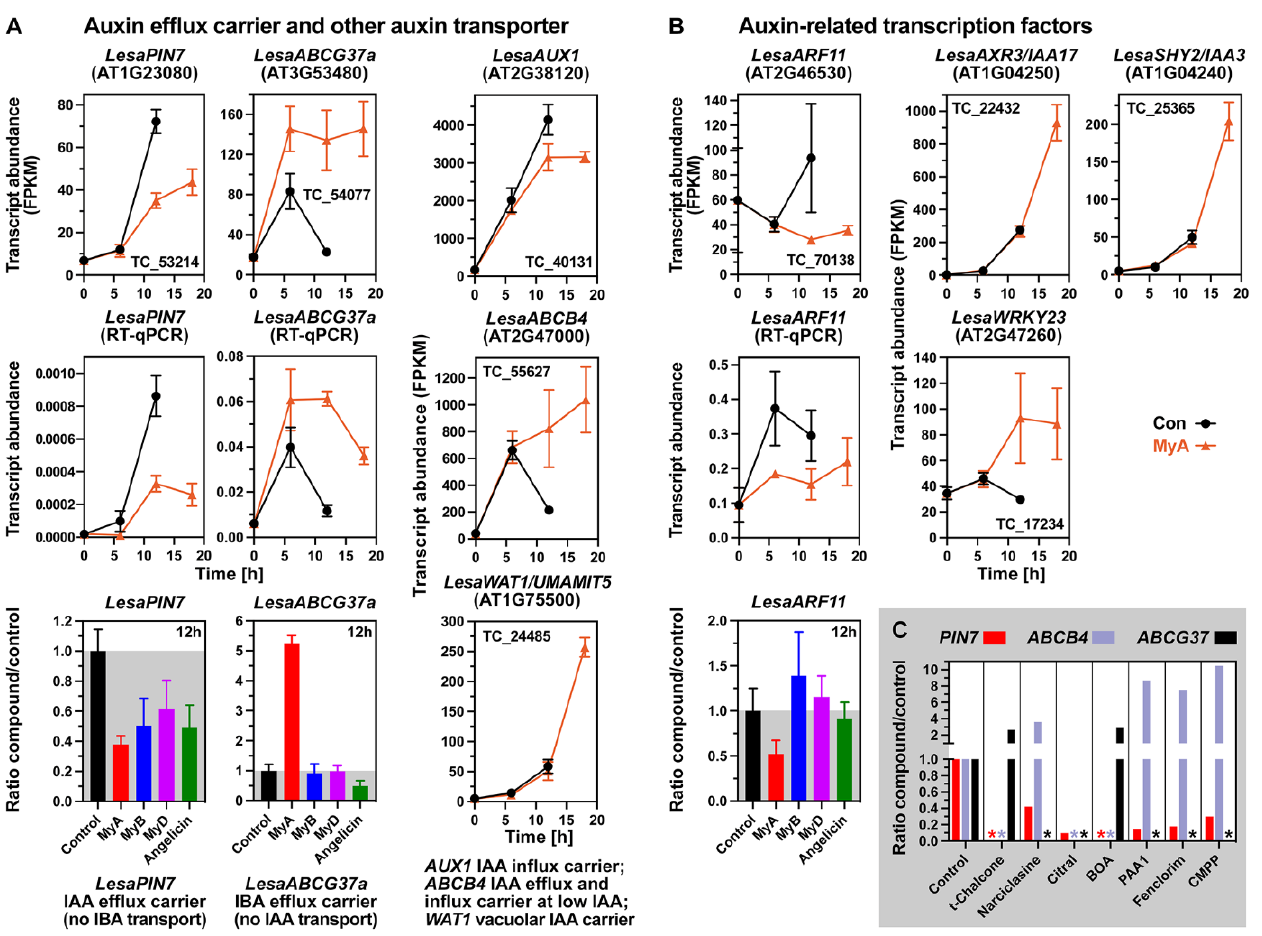
Figure 6. The effect of myrigalone A (MyA) and other compounds on the expression patterns of auxin-related transporter and signalling genes during Lepidium sativum (cress) seed germination. ( A ) Expression patterns of auxin transporter genes as affected by treatment of germinating cress seeds with MyA or other compounds. The specificity of the auxin transporters for either indole-3-acetic acid (IAA) or indole-3-butyric acid (IBA) is indicated. ( B ) Expression patterns of auxin signalling genes and the TF WRKY23. The names of L. sativum ( Lesa ) genes are associated with the corresponding A. thaliana orthologs (AGI in brackets); see abbreviations for full names of genes. Transcript abundances for L. sativum are presented as mean ± SEM values based on 4–5 (FPKM) and 3 (qRT-PCR) biological replicates; relevant transcript contigs (TC-IDs) are included for each graph. ( C ) Relative expression of PIN7 , ABCB4 and ABCG37 upon treatment of A. thaliana seedlings with various compounds.